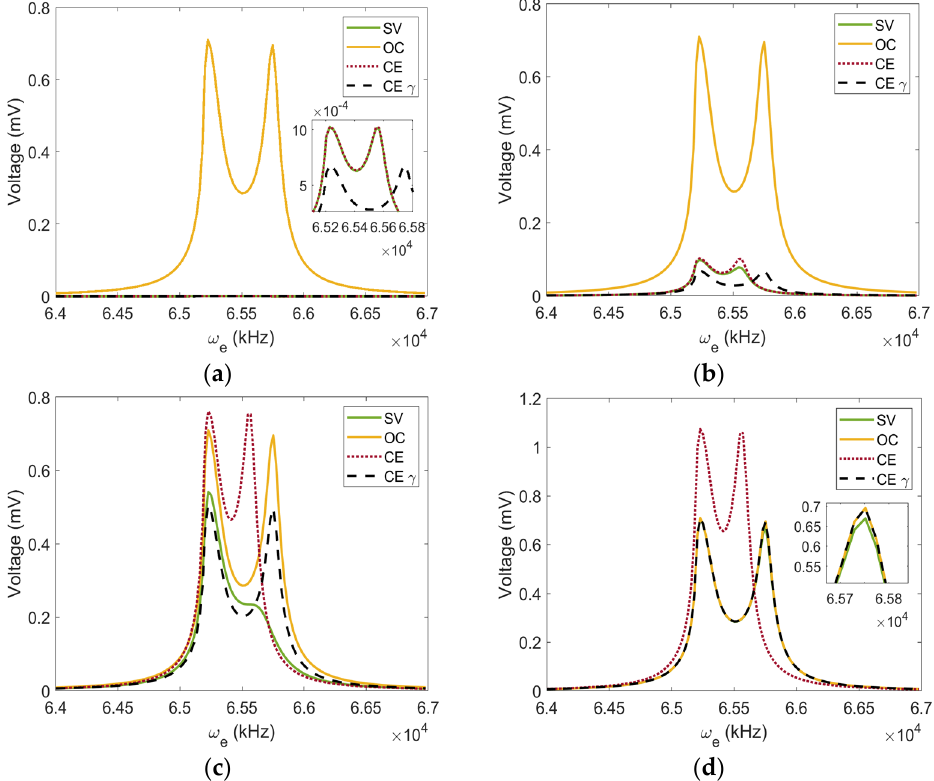
Figure 7. Voltage output variations as a function of the excitation frequency: ( a ) 𝑅 = 10 (cid:2871) Ω , ( b ) 𝑅 = 10 (cid:2873) Ω , ( c ) 𝑅 = (cid:2869) Ω , and ( d ) 𝑅 = 10 (cid:2876) Ω when 𝑉 (cid:3005)(cid:3004) = 1𝑉 , 𝑉 (cid:3002)(cid:3004) = 0.1 V, Ω = 80 (cid:3045)(cid:3028)(cid:3031) (cid:3004) (cid:3291) (cid:3104) (cid:3289)